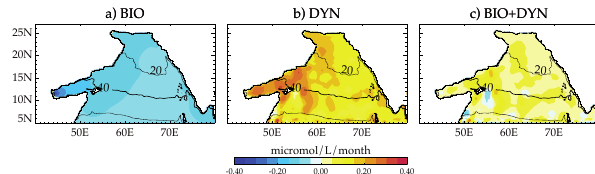
Fig. 2. Simulated annual trends of oxygen averaged between 200 and 1500m: (a) biological trend Fig.2. Simulatedannualtrendsofoxygenaveragedbetween200and1500m: a)biologicaltrend (cid:0) ∂O 2 ∂t (cid:1) Bio ,b) (cid:16) ∂ O (cid:17) dynamical trend (cid:0) ∂O 2 ∂t (cid:1) Dyn and c) residual (cid:0) ∂O 2 ∂t (cid:1) = (cid:0) ∂O 2 ∂t (cid:1) Bio + (cid:0) ∂O 2 ∂t (cid:1) Dyn . Units are in µ mol.L − 1 .month − 1 . 2 and (c) residual Contoursindicatetheoxygenconcentrationin µ mol.L − 1 averagedbetween200and1500m. ∂t Dyn are in µmolL − 1 month − 1 . Contours indicate the oxygen concentra- tion in µmolL − 1 averaged between 200 and